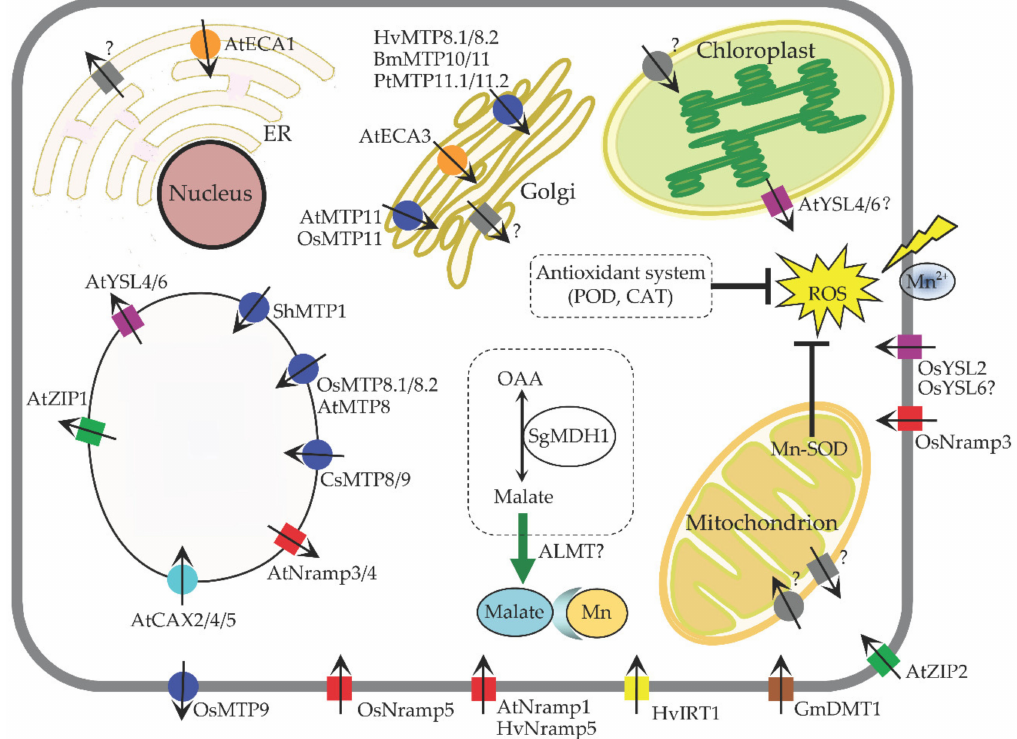
Figure 2. Summary of genes a ff ecting Mn transport and tolerance in plants. Squares: Import into the cytosol; circles: Export out of the cytosol; blue: MTP family; green: ZTP family; red: Nramp family; purple: YSL family; yellow: IRT family; orange: ECA family; cyan: CAX family; brown: DMT family; gray: unknown. ER: Endoplasmic reticulum; Nramp: Natural resistance-associated macrophage protein; MTP: Metal tolerance protein; DMT: Divalent metal transporter; ZIP / IRT: Zinc-regulated transporter / iron-regulated transporter-like proteins; YSL: Yellow stripe-like protein; CAX: Cation exchanger; ECAs:ER-typecalciumATPases; MDH:Malatedehydrogenase; ALMT:Aluminum-activated malate transporter; OAA: Oxaloacetate; ROS: Reactive oxygen species; SOD: Superoxide dismutase; POD: Peroxidase; CAT: Catalase. At: Arabidopsis thaliana ; Os: Oryza sativa ; Gm: Glycine max ; Hv: Hordeum vulgare ; Mt: Medicago tvuncatula ; Cs: Cucumis sativus ; Sh: Stylosanthes hamata ; Sg: Stylosanthes guianensis ; Le: Lycopersicon esculentum ; Bm: Beta vulgaris subspecies maritima; Pt: Populus trichocarpa . Question marks behind some genes mean that the exact roles of these genes or their localizations remain to be further